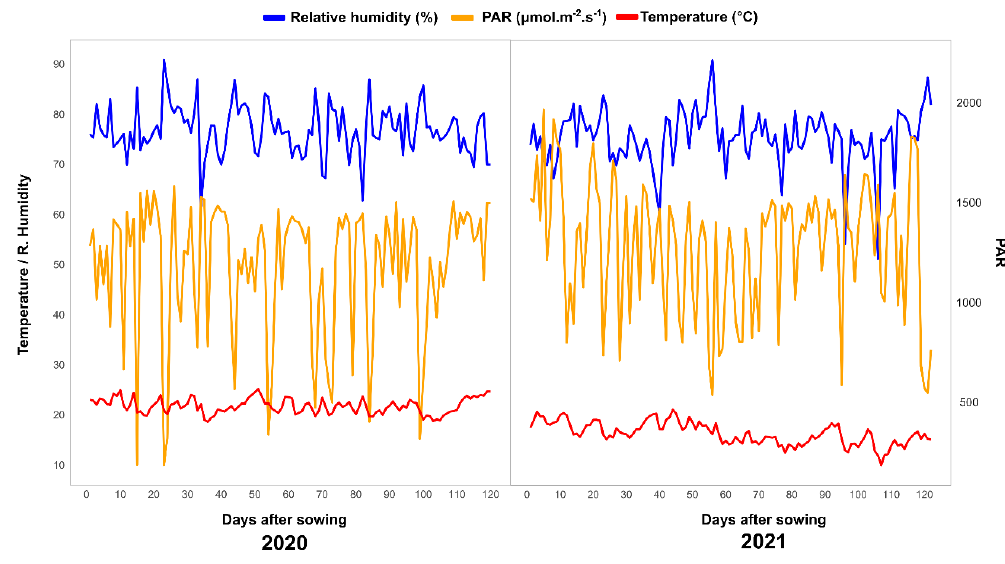
Figure 6. Environmental conditions (relative humidity, photosynthetically active radiation, and average temperature) observed in experiments with 50 popcorn lines cultivated in the 2020 and 2021 crop seasons.